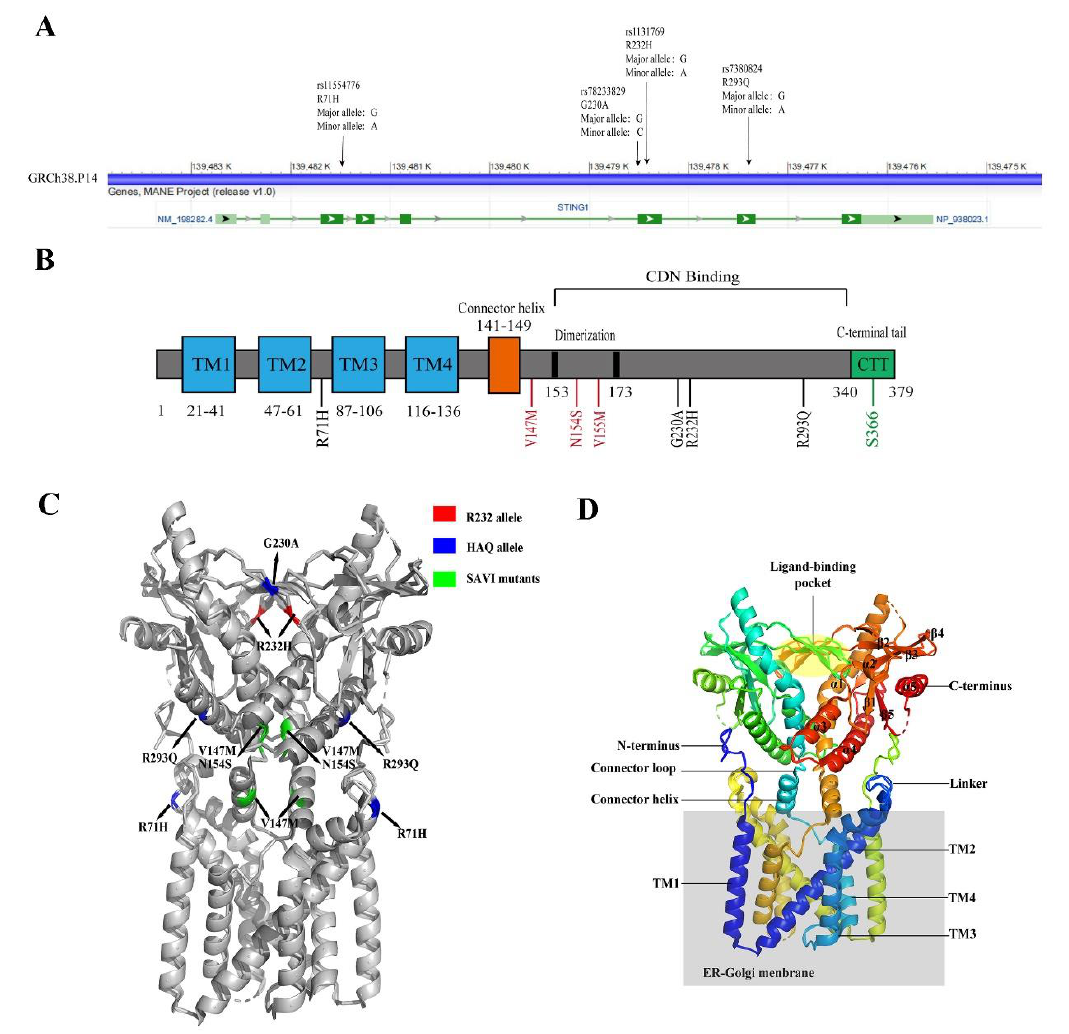
Figure 2. The structure of hSTING. ( A ) The hSTING gene map (NCBI reference sequence: NC-000005.10), annotated with common SNPs. ( B ) Schematic diagram of the hSTING protein domain. Transmembrane domains are marked in blue, common human mutation points are marked in black, regions related to IRF3 activation are marked in green, and SAVI mutation points are marked in red. ( C ) The crystal structure of the hSTING protein (PDB: 7SII). R232 is marked in red, the HAQ mutation point is marked in blue, and the SAVI mutation point is marked in green. ( D ) Representation of the STING structure (PDB: 7SII). The secondary protein structure, N-terminus, and C-terminus are numbered. The ER–Golgi membrane is colored in gray.